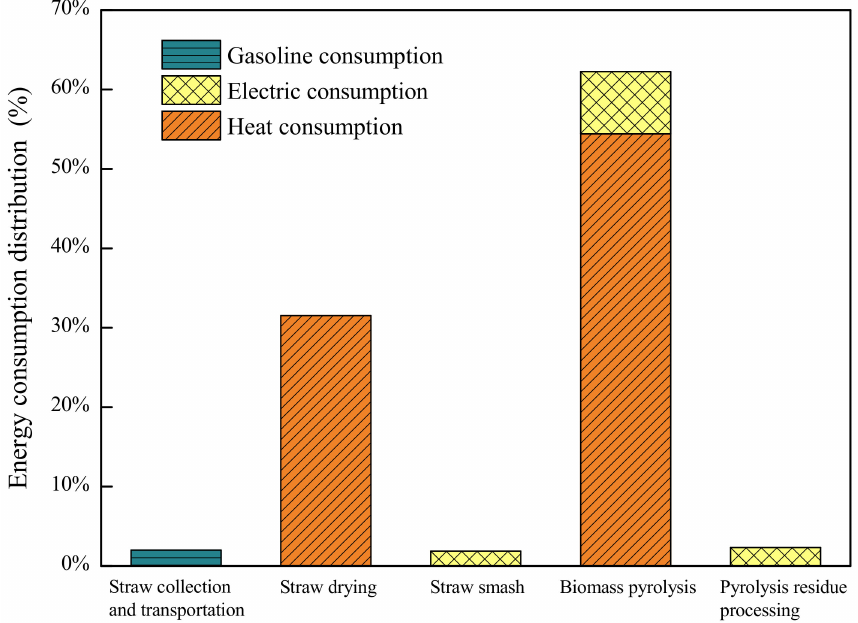
Figure 3. Energy consumption distribution of the non-phase-transition drying pyrolysis and mass conversion